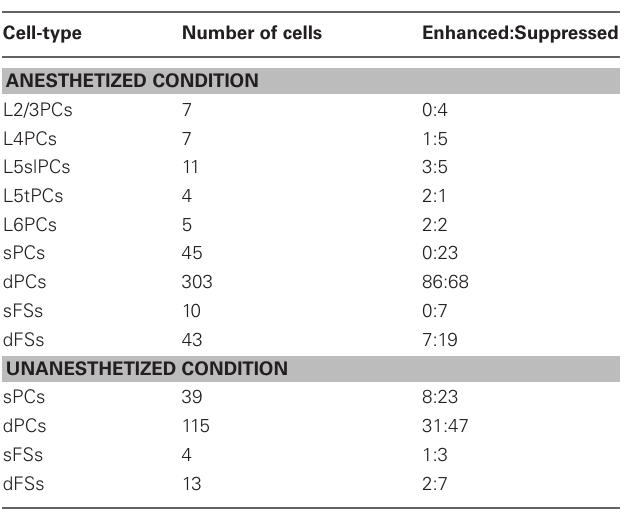
Table 1 | Summary of state-dependent and cell-type-specific spontaneous firing.